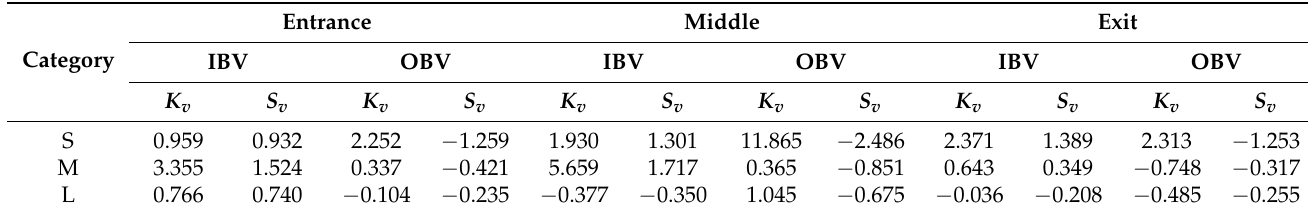
Table 4. Kurtosis and skewness assessment